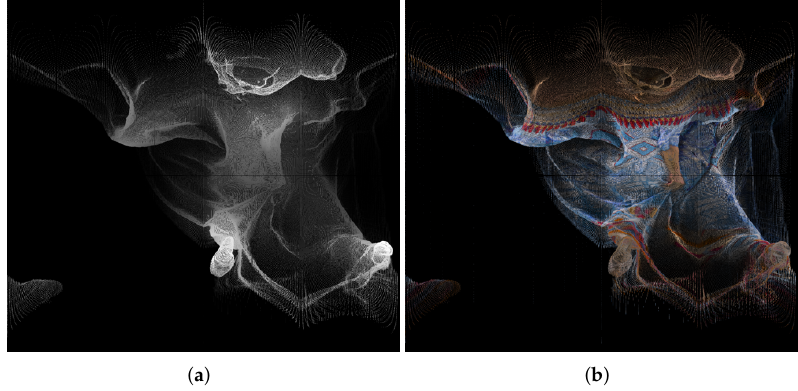
Figure 9. Panorama images created using point cloud “longdress_vox10_1060.ply” from the Pannini projection, for the geometry ( a ) and texture ( b